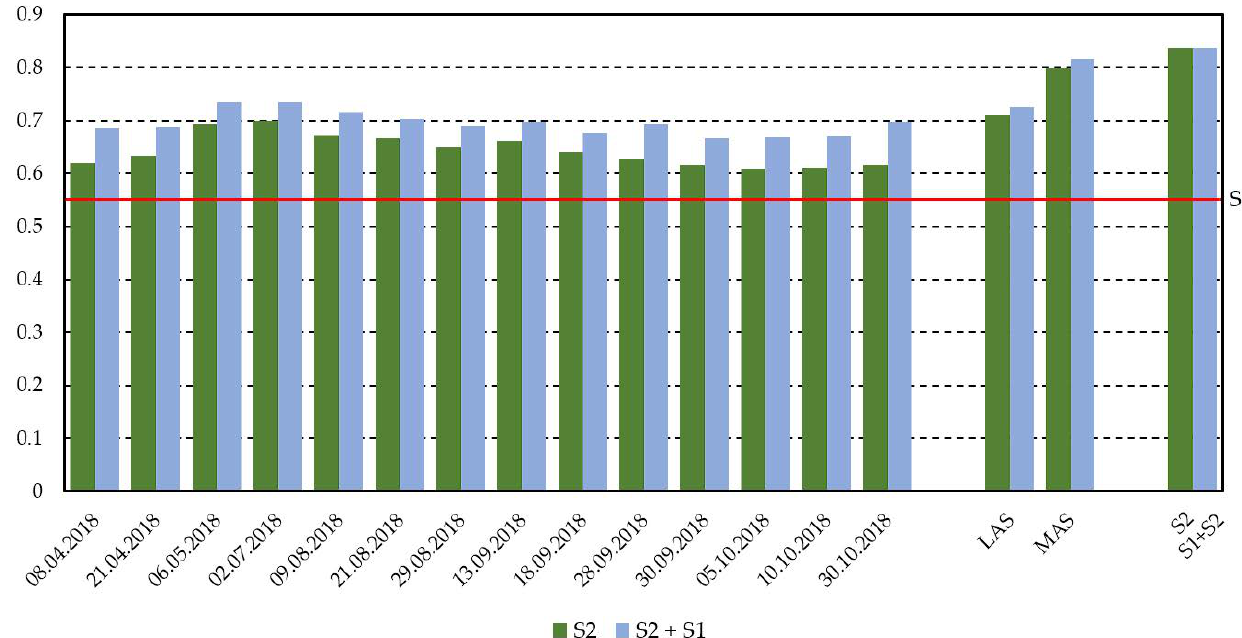
Figure 3. Overall accuracy of models using monotemporal Sentinel-2 (S2) scenes as well as two seasonal selections using the three least- (LAS) and the three most-performing S2 scenes (MAS), with and without Sentinel-1 (S1) combination. Also shown are the results when using all available S2 scenes with and without S1 combination. The red horizontal line highlights the results of the model based on S1 data